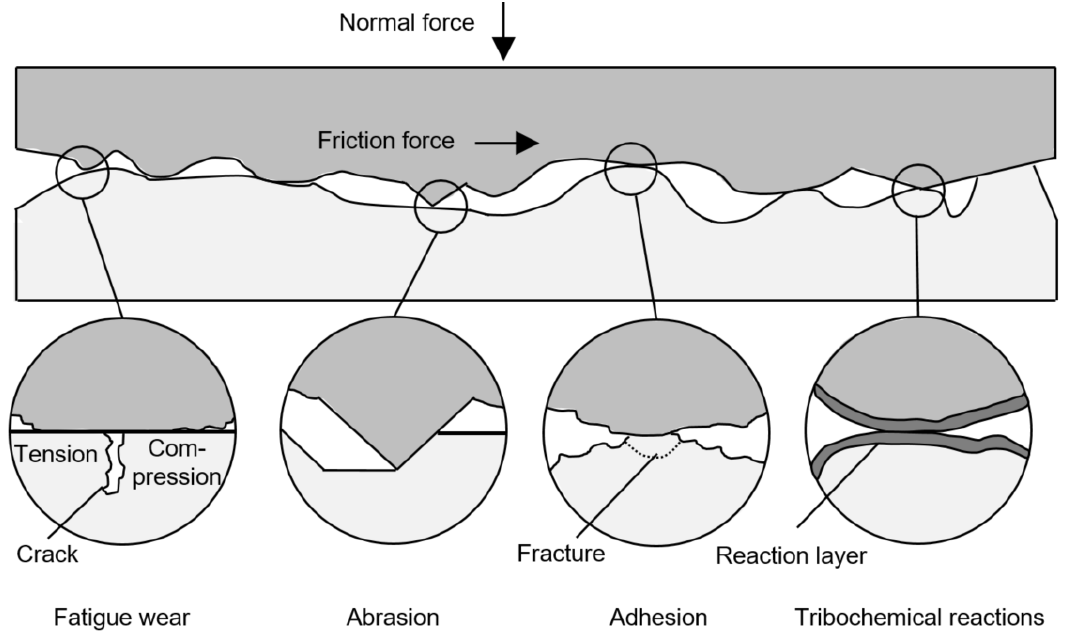
Figure 1. Wear mechanisms of tribological systems according to [10].